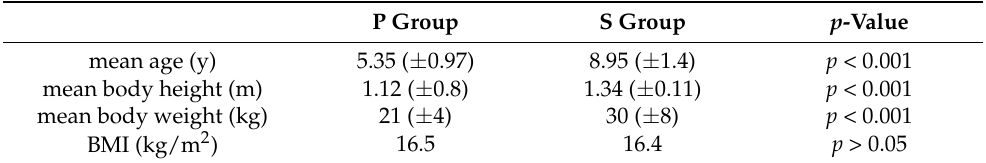
Table 2. Characteristics of the groups. Differences between younger (P group) and older (S) group. P Group S